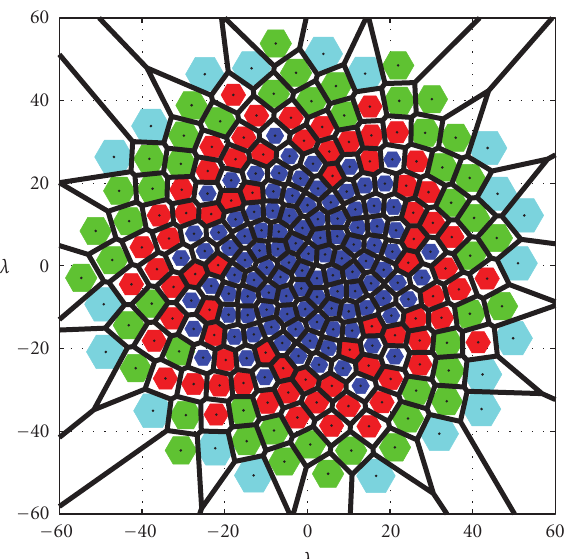
Figure 9: Hexagonal subarray positions and dimension after postprocessing.